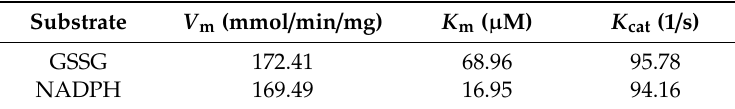
Figure 5. Lineweaver-Burk double reciprocal plots of rPsGR with respect to GSSG ( ■ ) and NADPH (●). Activity was measured as standard described. Every experiment was done in triplicates. Table 5. Kinetic constants of the rPsGR.